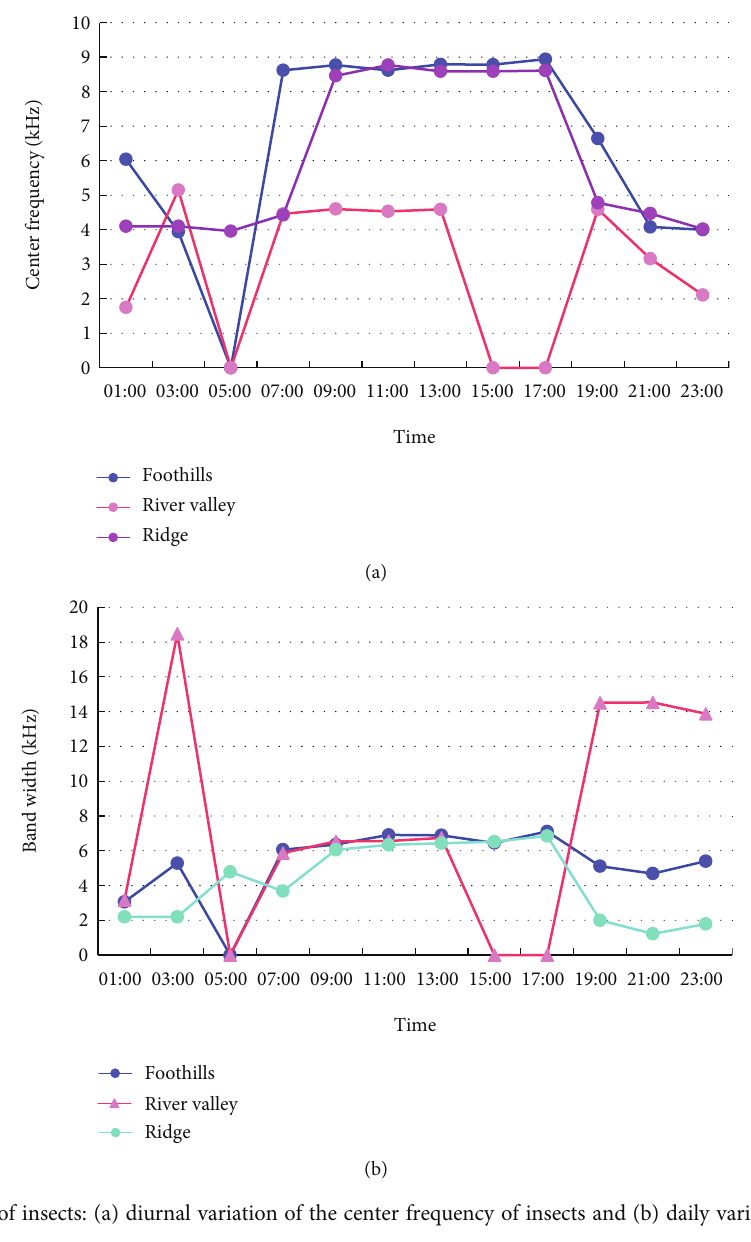
Figure 10: Daily changes of insects: (a) diurnal variation of the center frequency of insects and (b) daily variation of insects ’